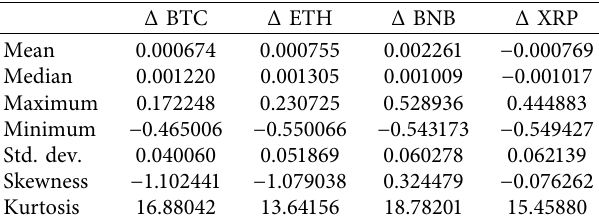
Table 1: Description of our data (this table describes the main characteristics of the data we